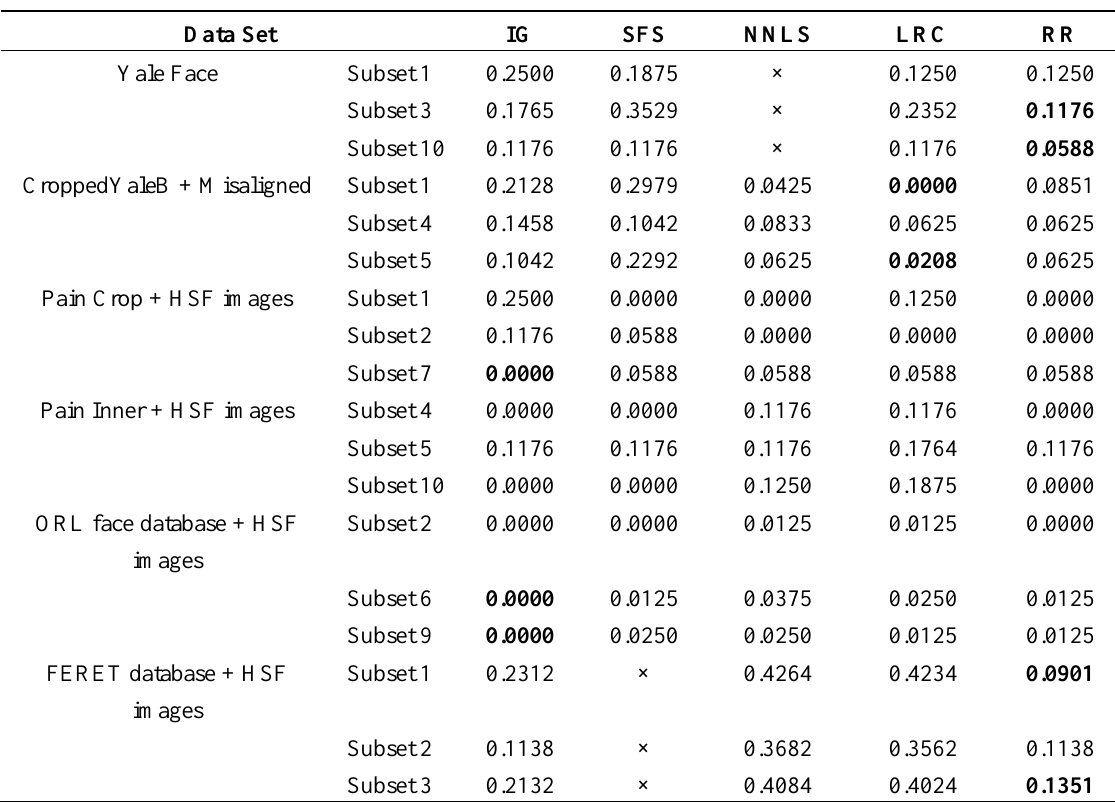
Table 4. Accuracy comparison of Information Gain, Sequential Forward Selection, RR - based distance, Non - Negative Least Squares classification, and Linear Regression